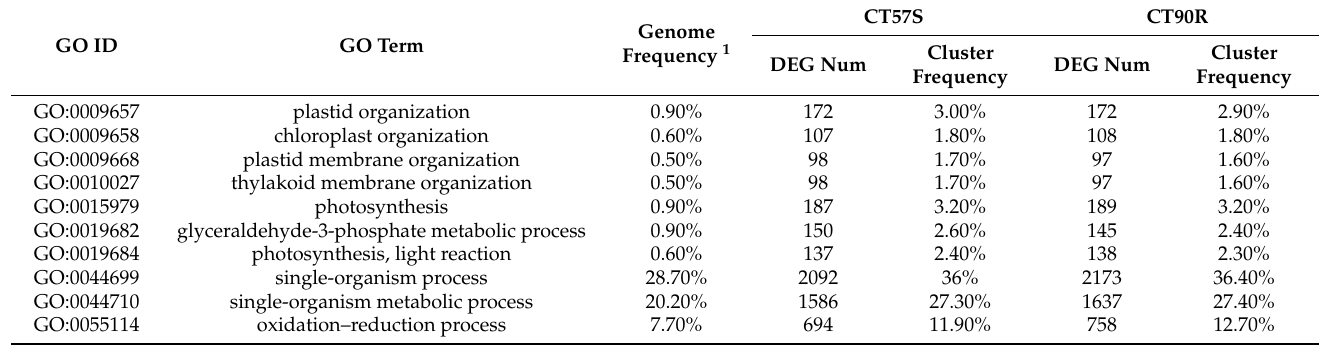
Figure 5. DEGs identified in different comparing pairs. ( A , B ) are statistical data of DEGs in comparing a pair of leaf vs. root. ( C , D ) are statistical data of DEGs in comparing a pair of CT57S vs. CT90R. Table 3. Top 10 items in GO enrichment analysis of DEGs identified between leaves and roots.